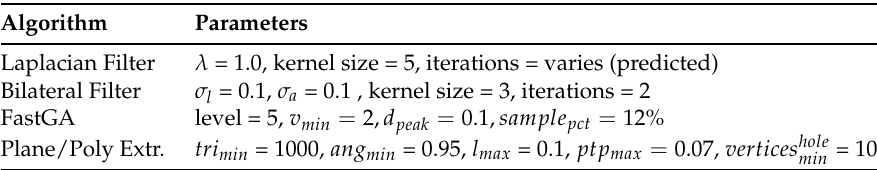
Table 9. Polylidar3D parameters for the SynPEB benchmark test set.